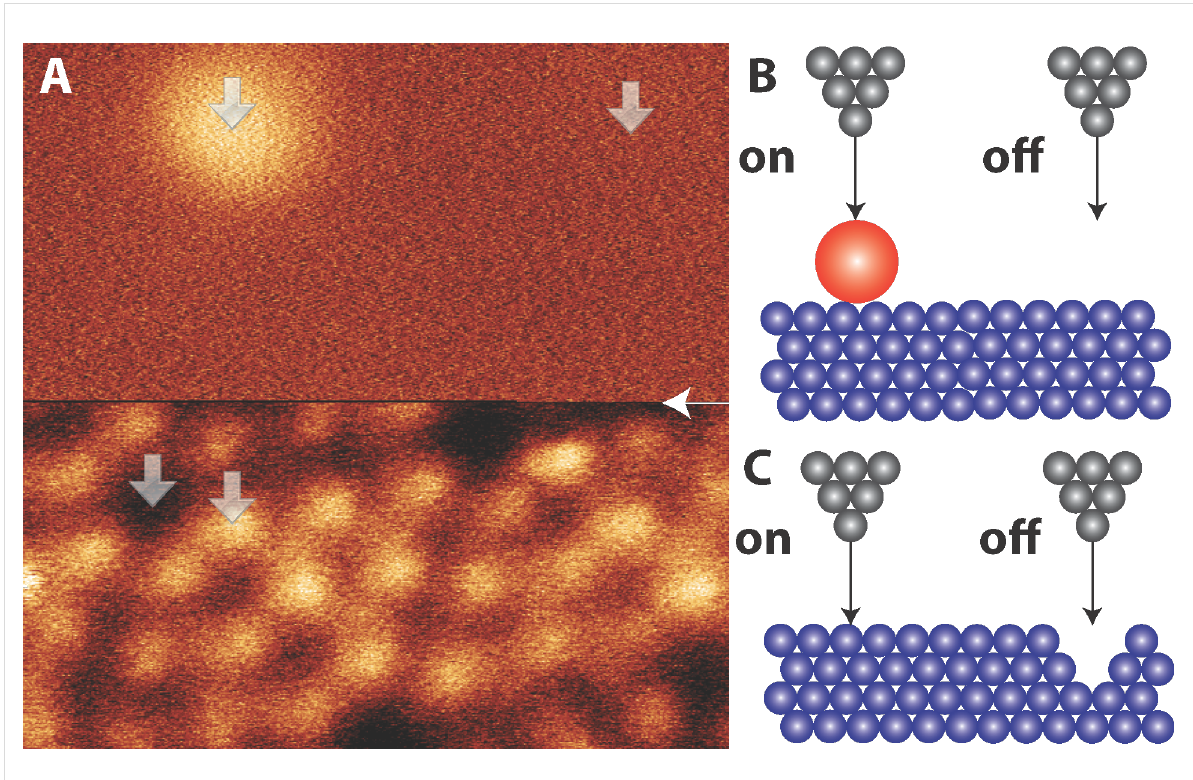
Figure 1: A) Constant Δ f NC-AFM image of a C 60 molecule adsorbed on the Si(111)-(7 × 7) surface showing atomic and molecular resolution. The position of the white arrow shows where the Δ f setpoint was changed from Δ f = − 53 Hz (adatoms, lower half of image) to Δ f = − 26.5 Hz (C 60 , upper half of image). Larger arrows show the Δ f ( z ) spectra positions. V gap = 0 V. A 0 = 0.11 nm. f 0 = 24866.3 Hz. B) and C) Cartoon representations showing the principle behind ‘on-minus-off’ measurements on a molecule and surface adatom